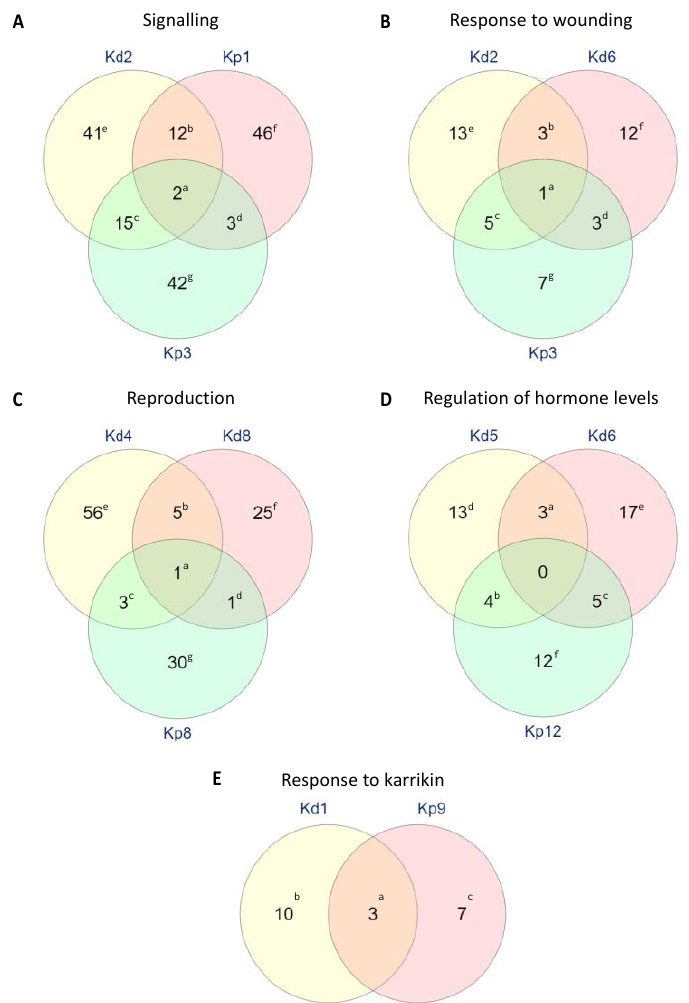
Figure 6. Number of genes in selected GO terms that are overlapped between different clusters of two Kalanchoë species, K. daigremontiana (Kd) and K. pinnata (Kp). Genes in signalling ( A ), response to wounding ( B ), reproduction ( C ), regulation of hormone levels ( D ) and response to Karrikin ( E ). The numerical value next to the species name symbol (Kd, Kp) represents the corresponding gene cluster in Figure 2. The numerical value in the Venn diagrams represents the number of genes. Superscript alphabets correspond to the list of genes in Table S1.